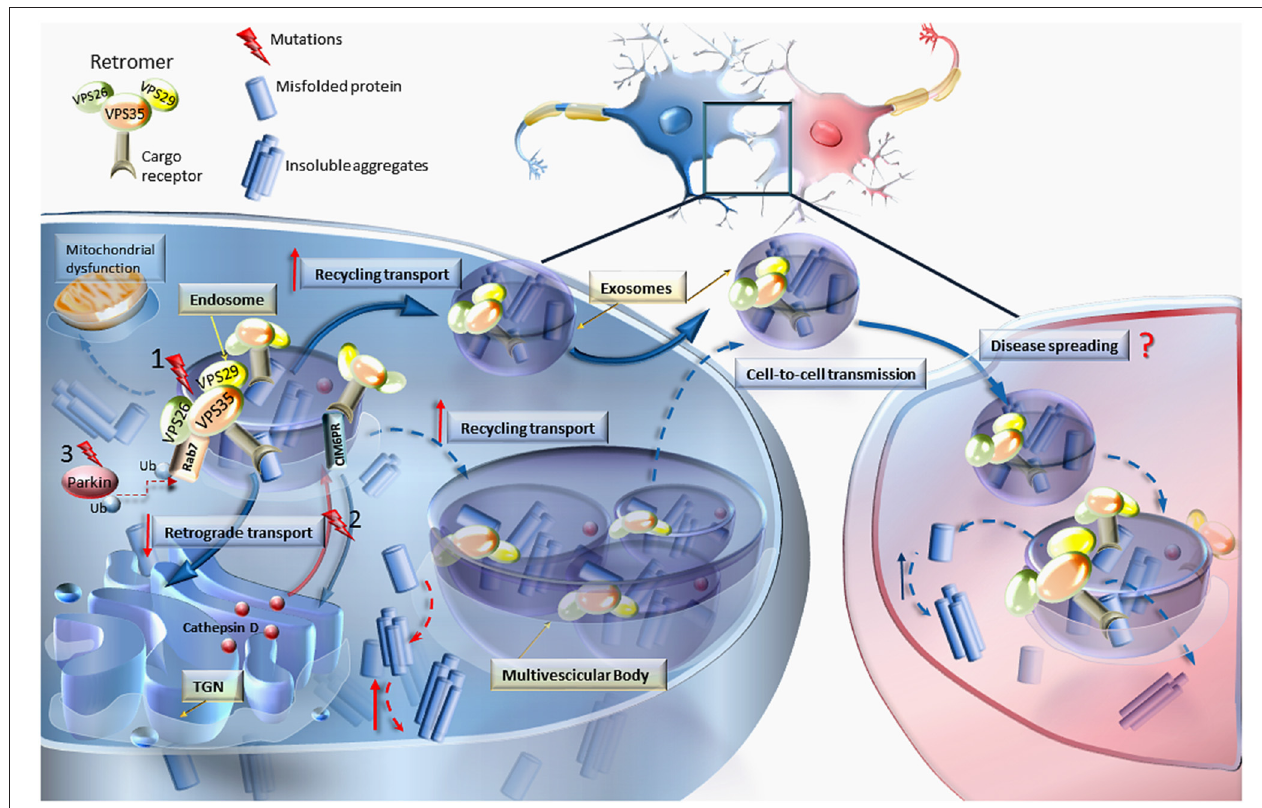
FIGURE 1 | VPS mutations and retromer dysfunction. This cartoon reports the most relevant effects of VPS dysfunction on the molecular mechanisms involved in cellular trafficking. Mutations (nr.1) occurring in any of the Vacuolar Protein Sorting components of the retromer (VPS35, VPS26, and VPS29) may lead to increased levels of misfolded proteins, thereby causing abnormal sorting and trafficking. In an attempt to get rid of misfolded proteins, the routine trafficking may shift from endosomes and trans-Golgi network (TGN) to the cell membrane to produce the release of aberrant cargoes. Diffusible retromers may be key in neurodegenerative disorders, posing this unconventional mechanism of cell-to-cell communication as a cause of disease spreading. Retromer dysfunction may also derive from mutations (nr.2) impairing the retrograde transport of cation-independent mannose-6-phosphate receptor (CIM6PR), which in turn becomes unable to bind cathepsin D and other proteases to the TGN, to be delivered to the endosome (Miura et al., 2014). Since cathepsin D is an endosome–lysosome protease which is crucial for degrading α -synuclein, this may explain the occurrence of α -synuclein accumulation also in the course of retromer-related PD. The relevance of the endosomal/retromer/exosome compartment in PD is supported by the interaction of VPS35 with parkin by promoting Rab7 ubiquitination. In fact, Parkin mutations (nr.3) are associated with retromer dysfunctions (Song et al., 2016). In line with consistent finding on mitochondrial alterations in PD, VPS35 was shown to